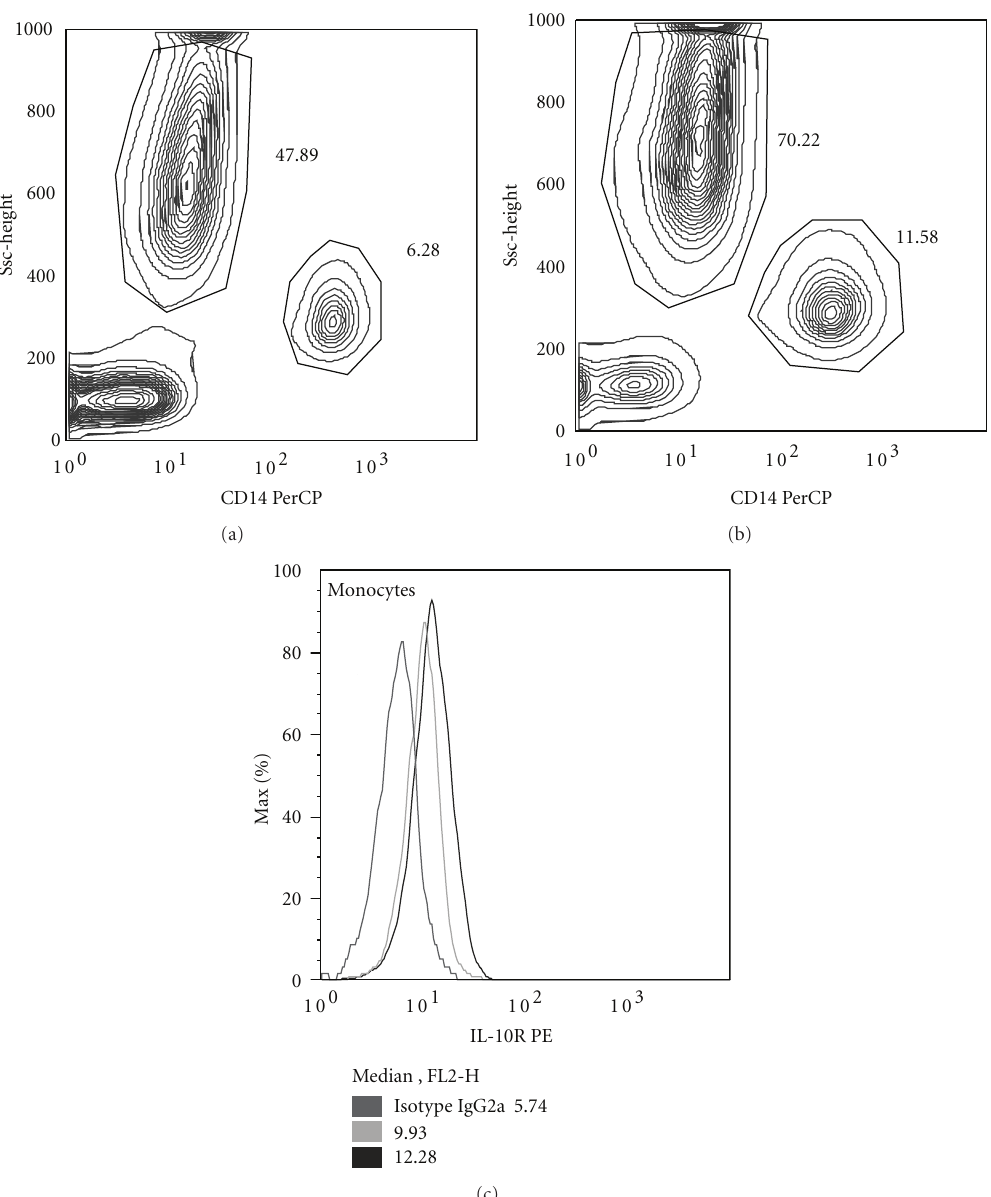
Figure 4: Illustration of changes in the expression of IL-10R on monocytes of conventional CPB patient. Monocytes are discriminated from other populations of cells by high expression of CD14 ( x -axis). (a) Leukocytes before surgery. (b) Leukocytes on the 3rd postoperative day. (c) Overlaid histograms of monocytes from (a) and (b). Although the expression of IL-10R on monocytes enhances on the 3rd day after surgery (black line), it is relatively weak considering the isotype control (dark grey line). Intracellular staining did not reveal higher expression of IL-10R in cells (data is not